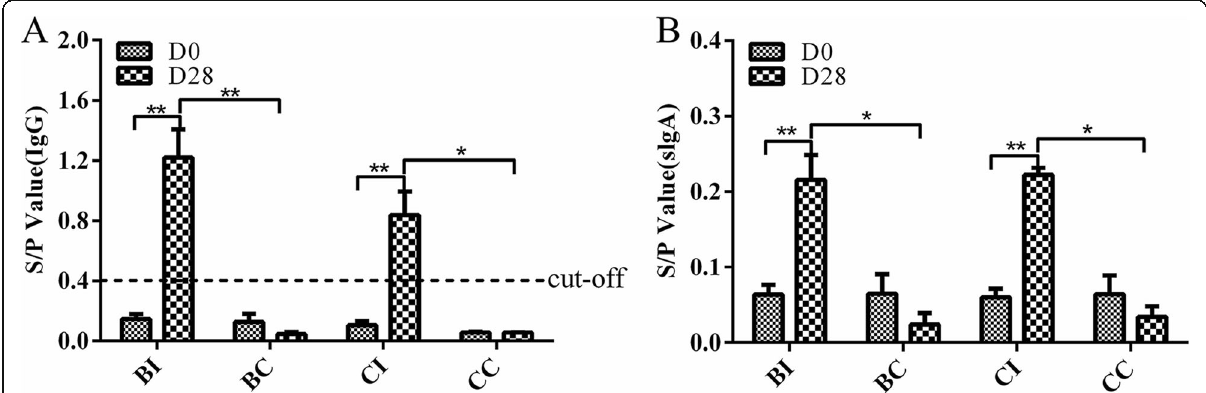
Fig. 2 Serum IgG antibody and nasal sIgA antibody titres detection of of all pigs from both Bama mininature pigs and conventional pigs. Serum and nasal swabs from all pigs were collected at 0 dpi and 28 dpi. D0: 0 dpi; D28: 28 dpi. a Serum IgG titres of M. hyopneumoniae from all pigs were tested by a commercialized ELISA kit. S/ P value = (sample OD 650 - negative control OD 650 )/(positive control OD 650 - negative control OD 650 ). S/ P values higher than the cutoff value of 0.4 were considered positive. *, P < 0.05, indicates serum IgG S/P values between the infected and control groups of conventional pigs were significantly different. **, P < 0.01, indicates serum IgG S/P values at 0 dpi and 28 dpi were extremely significantly different. b sIgA titres of M. hyopneumoniae collected from nasal swabs of pigs measured using a lab-prepared ELISA kit. S/P value = (sample OD 450 - negative control OD 450 )/(positive control OD 450 - negative control OD 450 ). *, P < 0.05, indicates nasal swab sIgA S/P values between the infected and control groups of both Bama mininature and conventional pigs were significantly different. **, P < 0.01, indicates nasal swab sIgA S/P values at 0 dpi and 28 dpi of infected pigs in both Bama mininature and conventional pigs were extremely significantly